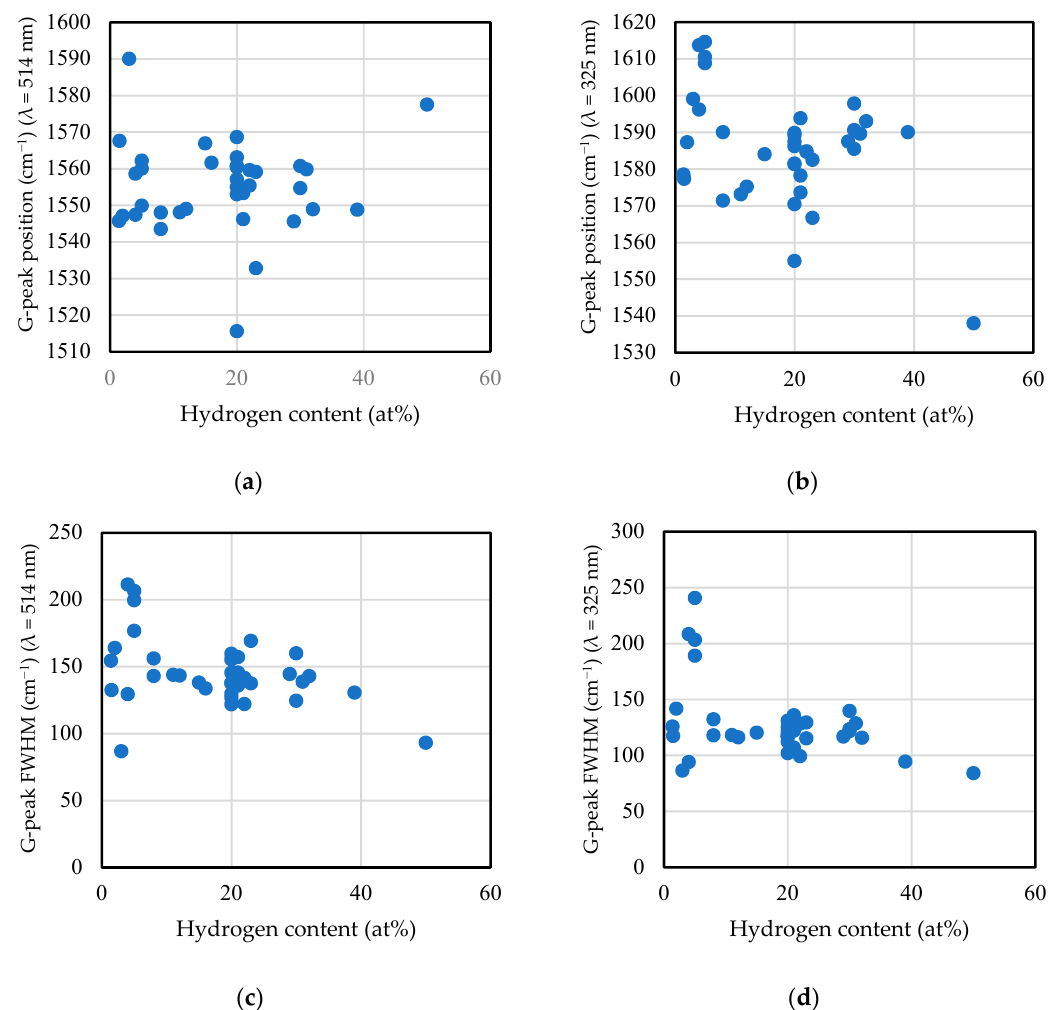
Figure 14. Influence of hydrogen content on the G-peak position and G-peak FWHM measured by ( a ) and ( c ) visible and ( b ) and ( d ) ultraviolet (UV) light Raman spectroscopic analyses.